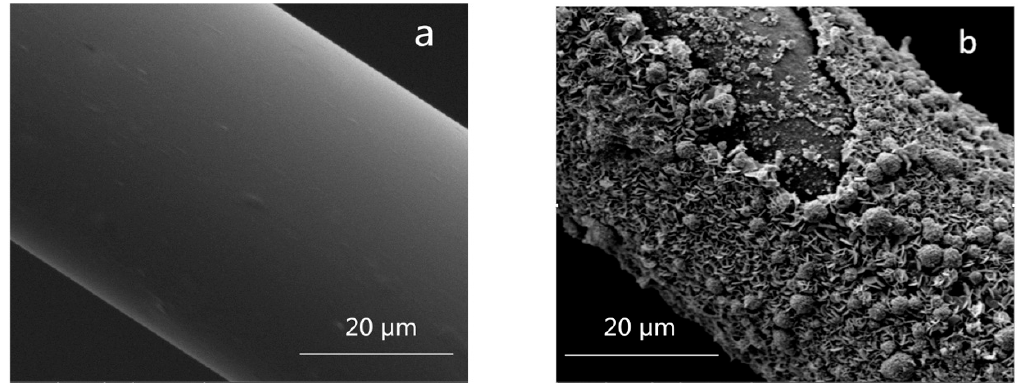
Figure 4. ( a ) Tensile strength retention of basalt fiber samples after alkali corrosion; ( b ) mass retention of basalt fiber samples after acid corrosion.